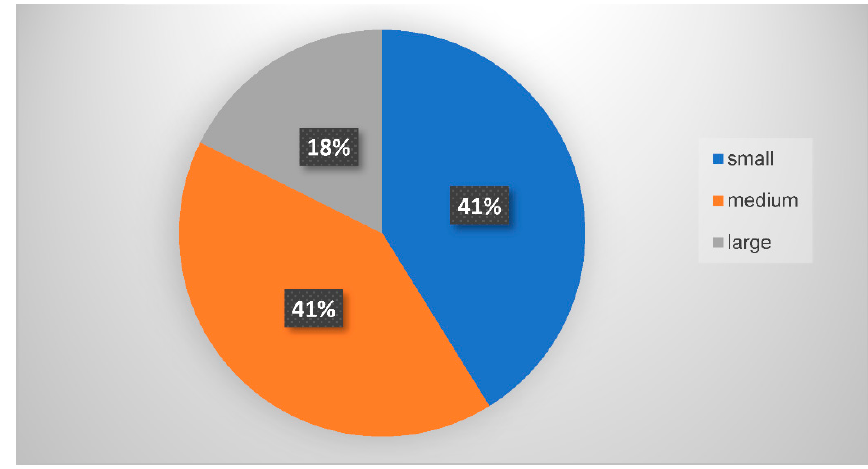
Figure 8. Percentage share of small, medium and large civil structures in research.